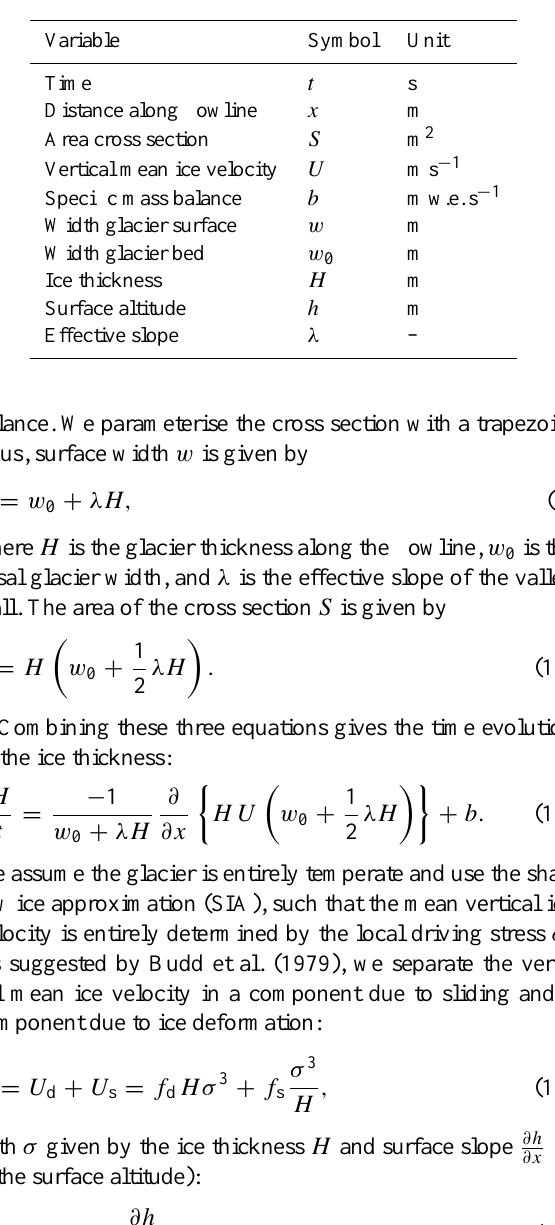
Table 3. Model variables of the ice-dynamical model.